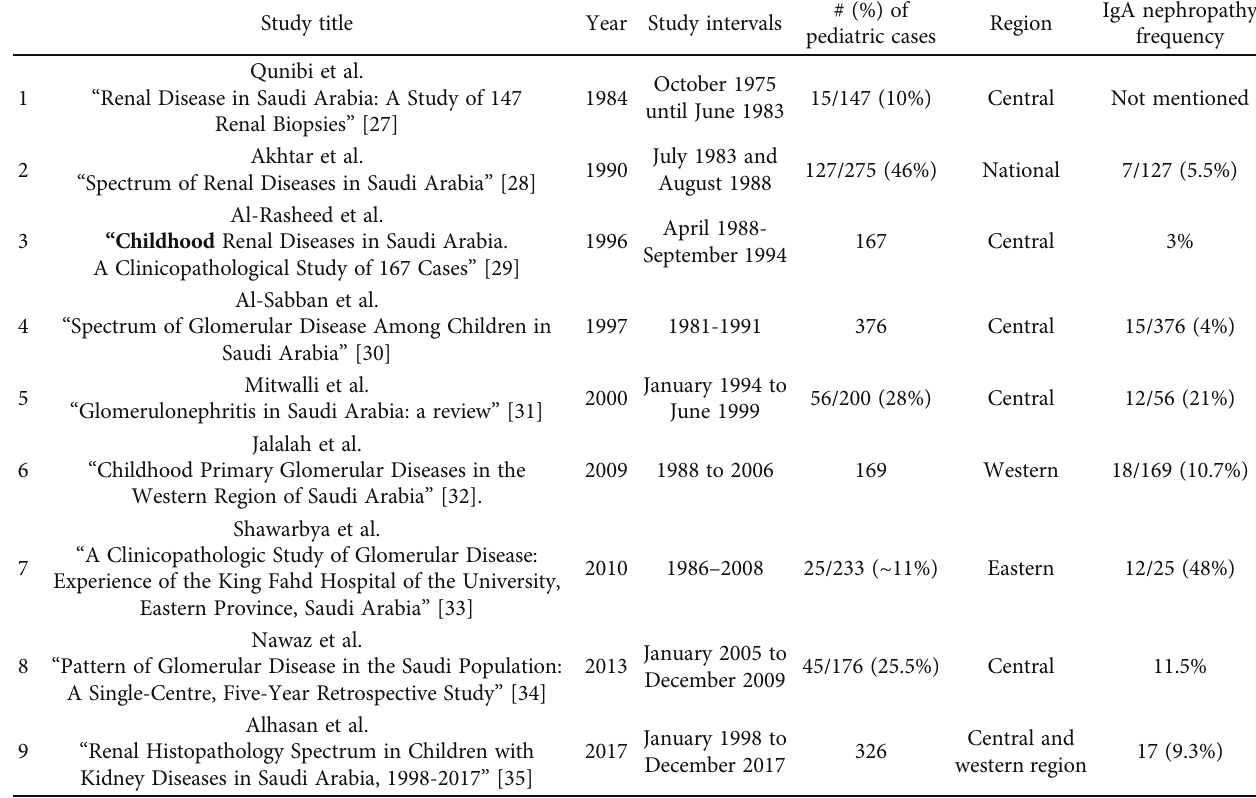
Table 1: List of local studies that described the prevalence of glomerulonephritis and included pediatrics or designated for pediatrics